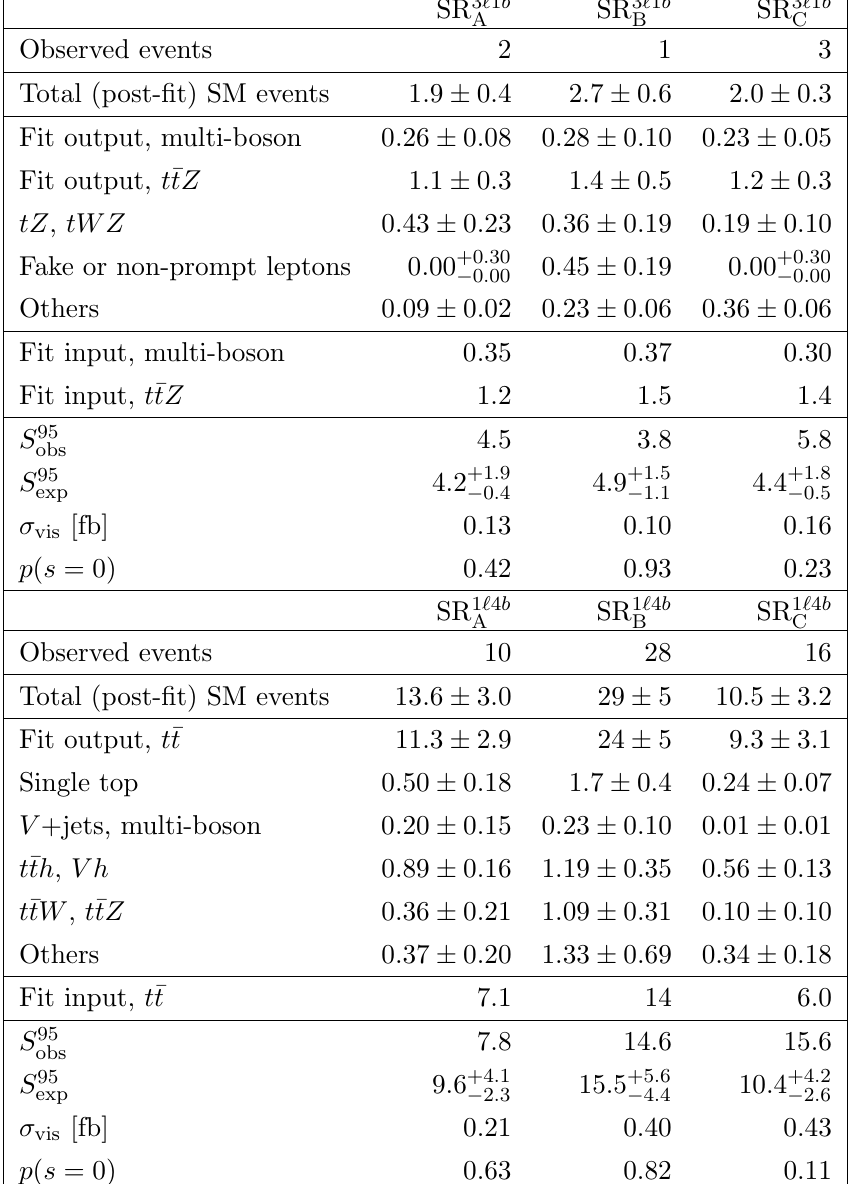
Table 9. Observed and expected numbers of events in the six signal regions. The nominal pre- dictions from MC simulation are given for comparison for those backgrounds ( t (cid:22) tZ , multi-boson for the 3 ‘ 1 b selection and t (cid:22) t for the 1 ‘ 4 b selection) that are normalised to data in dedicated control regions. For SR 3 ‘ 1 b , SR 3 ‘ 1 b A B